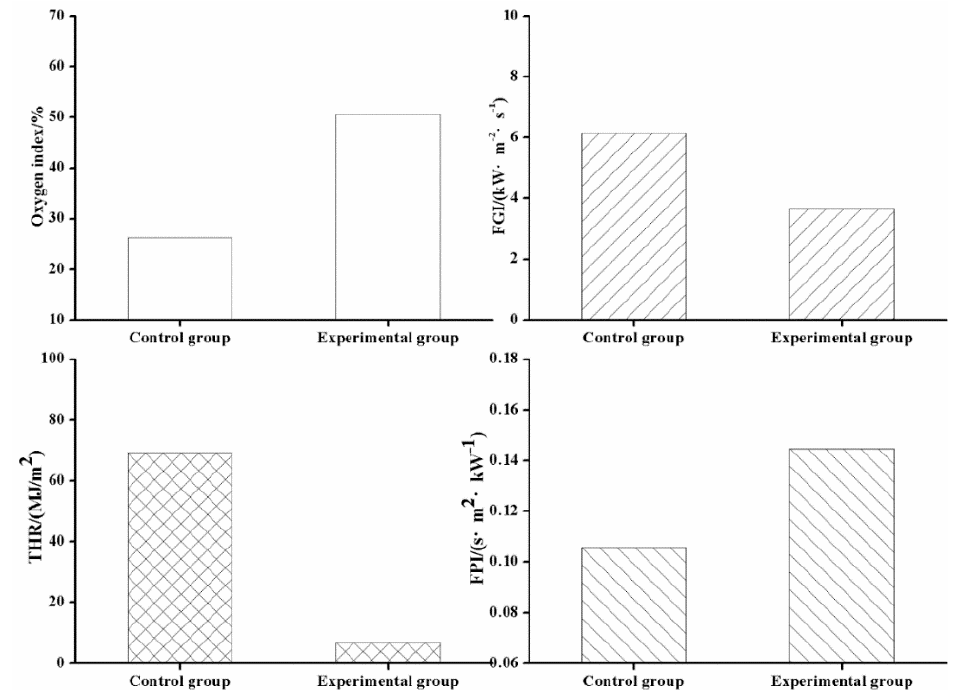
Figure 1. Results of plywood combustion via a cone calorimeter test.